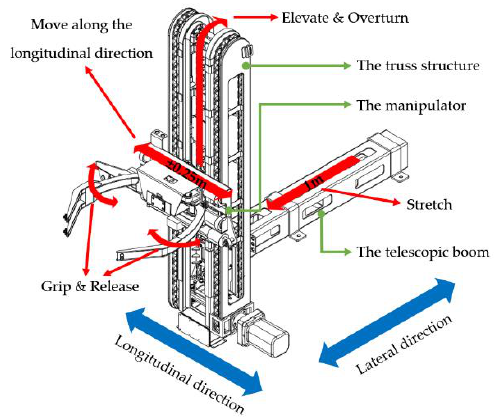
Figure 1. The trash can-handling robot.